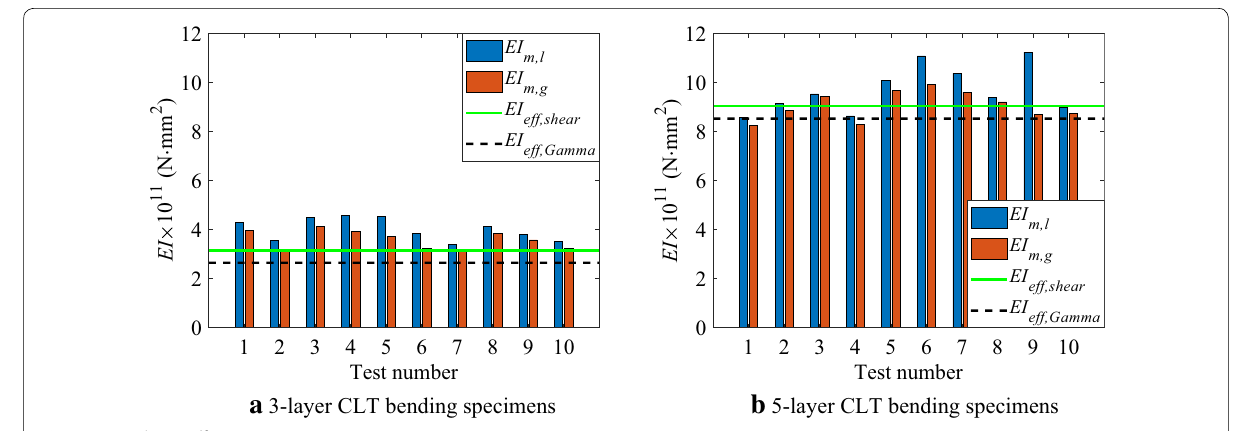
Fig. 12 Bending stiffness comparison